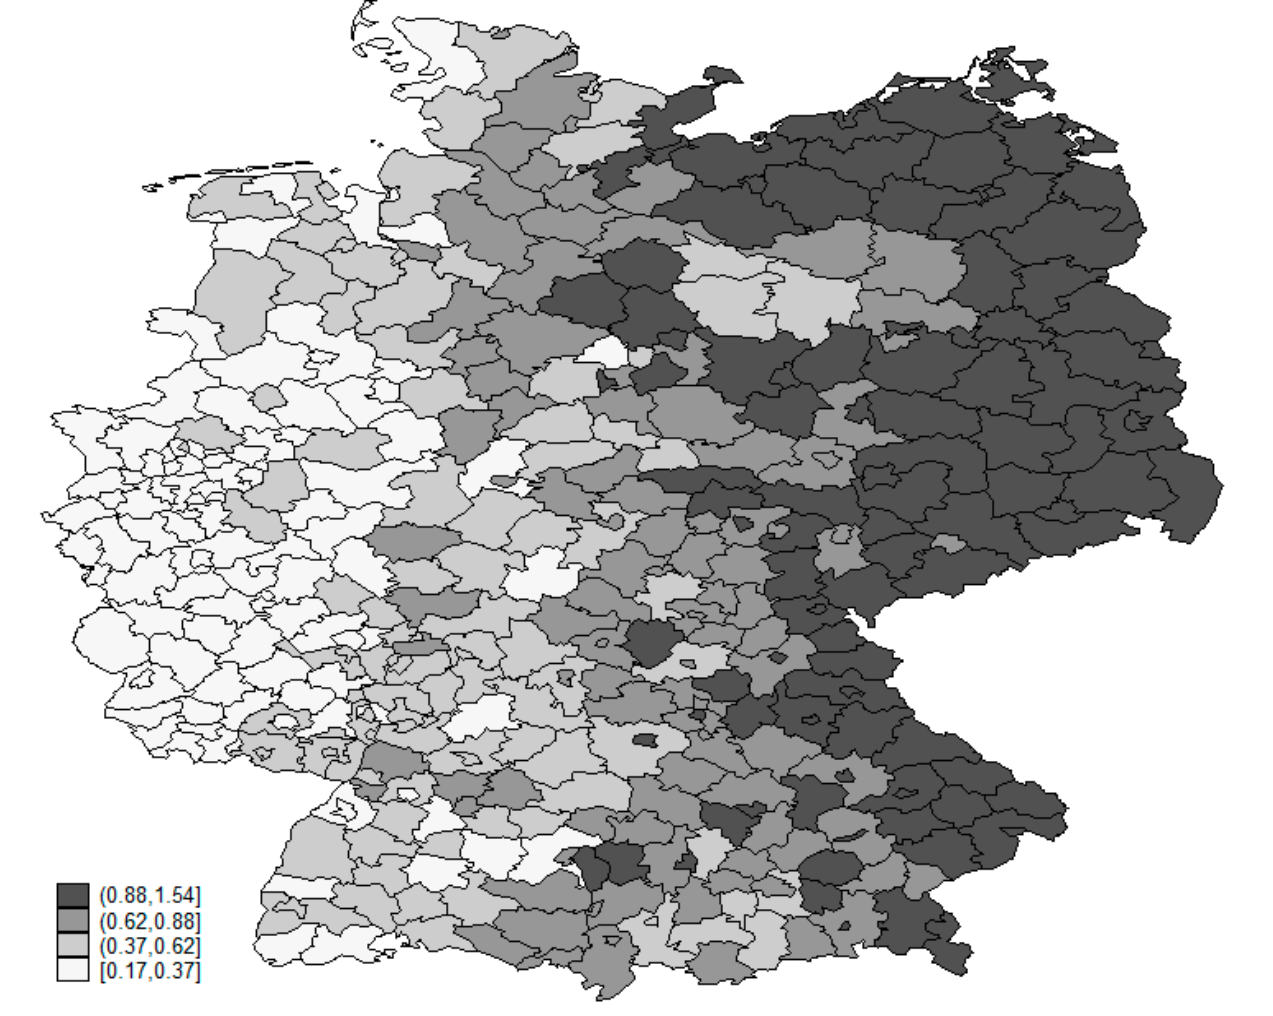
Figure 4. Spatial Variation in Coefficients of Public Funds: Total Investments.